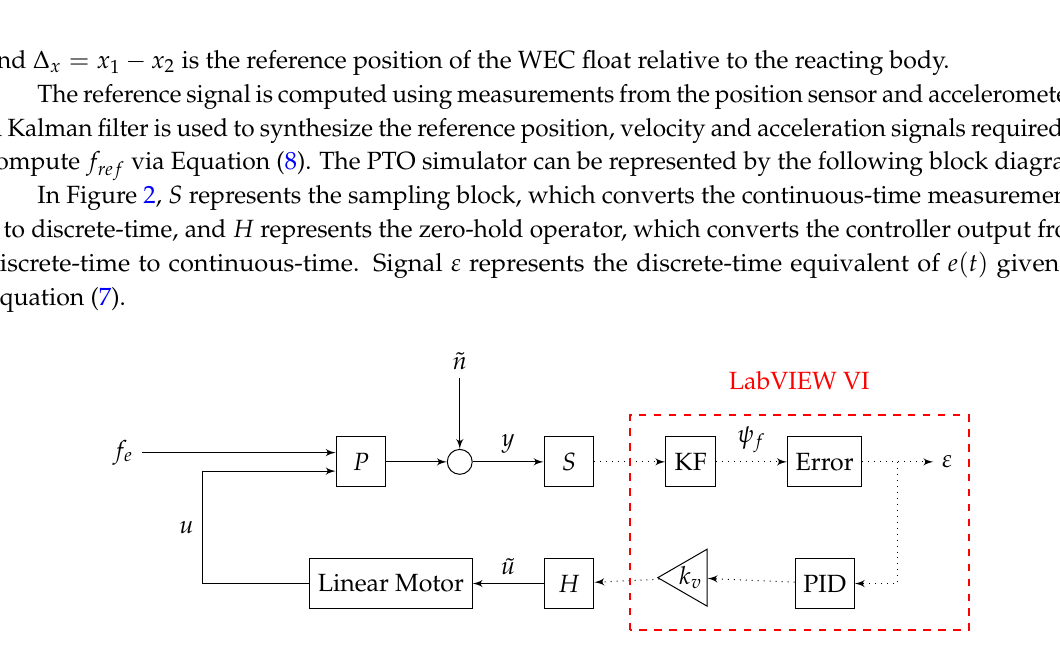
Figure 2. System diagram for the original PTO